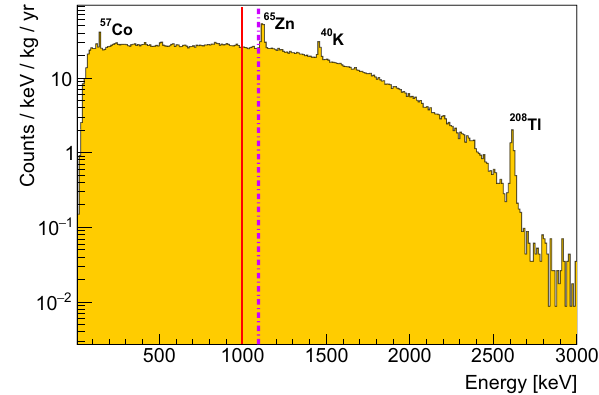
Fig. 1 Energy spectrum of the events detected by ZnSe crystals after dataselectionperformedwithbasiccutsonthepulseshapeandrequiring that a single crystal in the array triggered the event. Red bar: Q value of 70 Zn (997.1 ± 2.1keV). Dashed purple bar: energy of the γ ray produced by 64 Zn in Signature C (Sect. 5). We highlight that Signature C is partly overlapped to the peak of 65 Zn